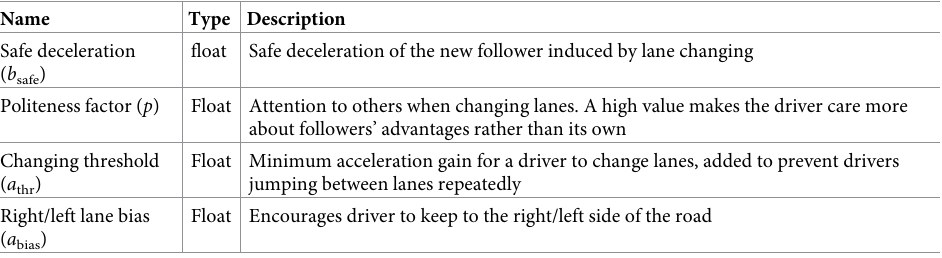
Table 6. Attributes related to lane